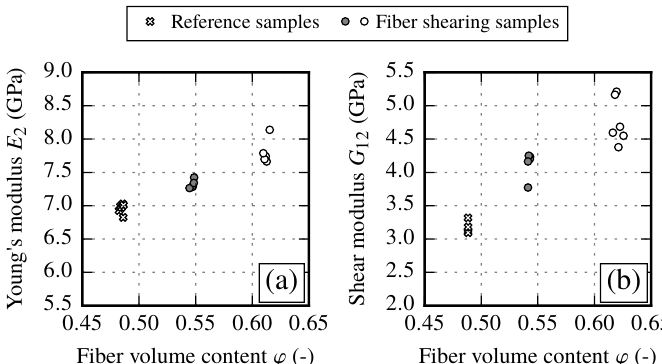
Figure 12. Fiber shearing samples—transverse E 2 ( a ) and shear modulus G 12 ( b ) at different fiber volume contents.